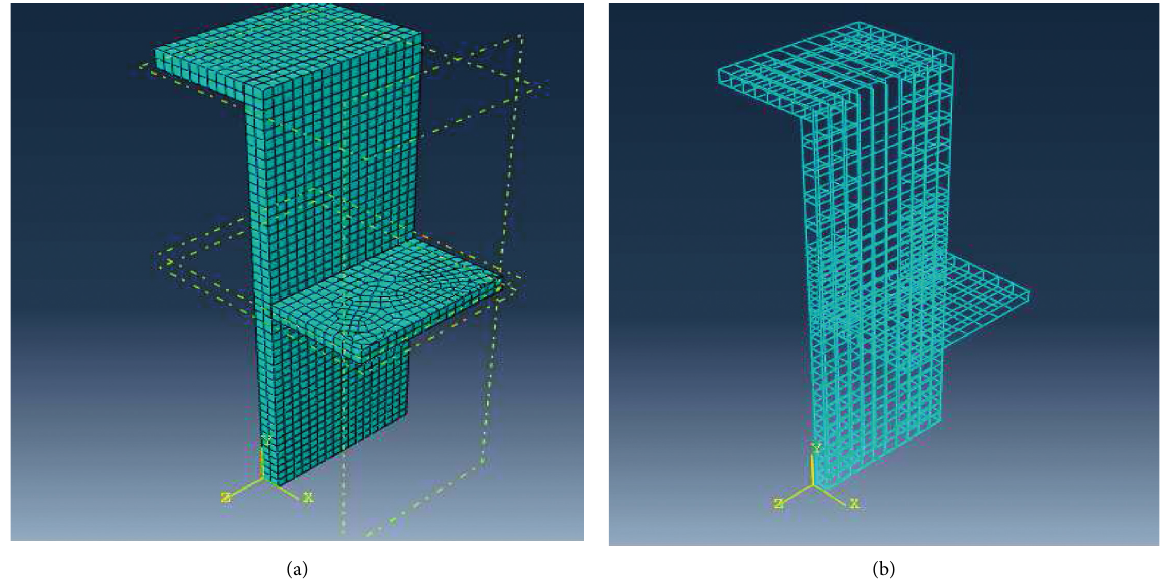
Figure 7: Meshing size and element type for each part of shear wall-slab connection. (a) Plain concrete shear wall-slab joint and (b) steel